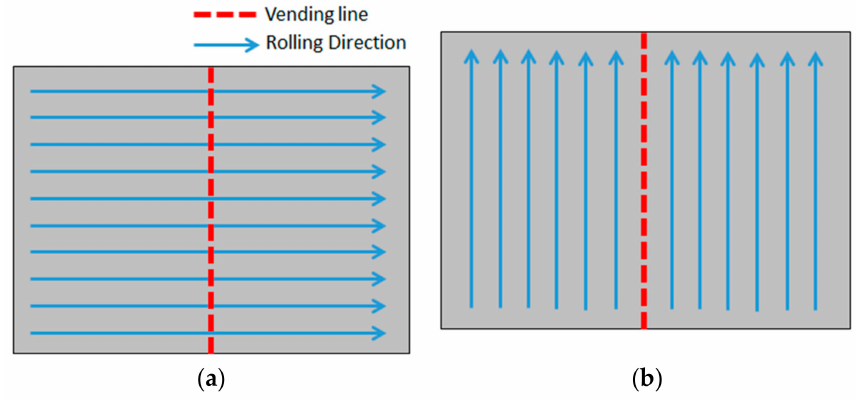
Figure 6. Rolling direction of CR980 for V-bending test: ( a ) 90 ◦ (RD90 ◦ ); ( b ) 0 ◦ (RD0 ◦ ).